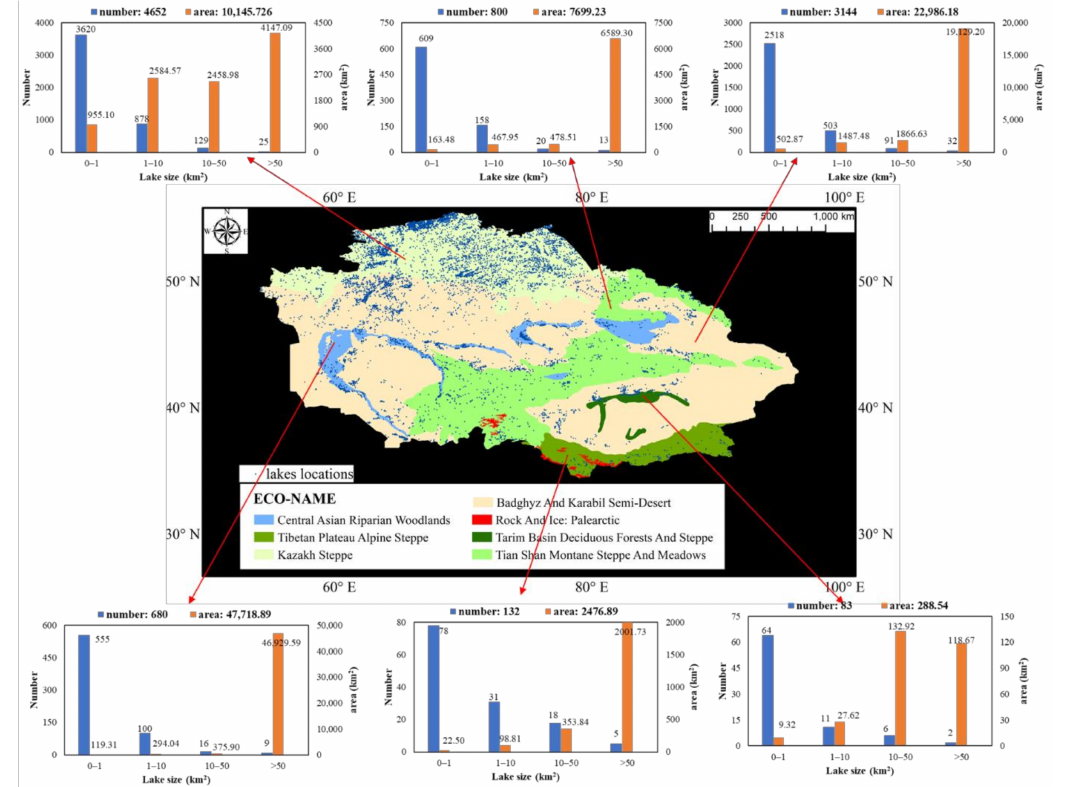
Figure 4. Number and area of lakes within seven terrestrial ecological zones in Central Asia